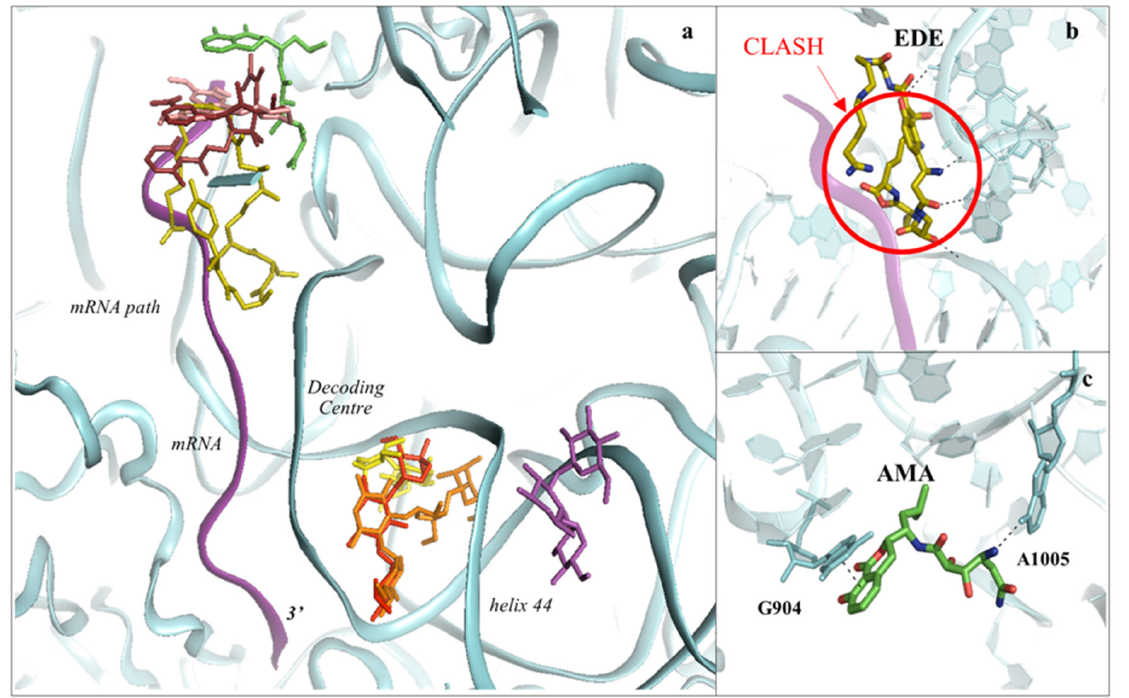
Figure 6. The SSU can be targeted by protein synthesis inhibitors at two main regions. ( a ) Overview of the binding sites for small molecules binding to the 40S subunit. Amicoumacin A (AMA) in green (PDB: 5I4L), cryptopleurine in salmon (PDB: 4U55), edeine (EDE) in olive green (PDB: 4U4N) and pactamycin (PAC) in ruby (PDB: 4U4Y). mRNA is also shown as a ribbon and coloured in purple. Inhibitors have been shown to bind with high specificity to the mRNA path and the decoding centre (DC), thus impairing tRNA–mRNA translocation and altering the translation fidelity process; ( b ) zoom-in and details of interaction for EDE within the mRNA path in correspondence with where the E-site tRNA should interact. The clash with mRNA (shown in red) would prevent the formation of the preinitiation complex; ( c ) zoom-in and details of interaction for AMA within the mRNA path. AMA forms a π – π stacking interaction with the conserved rRNA residue G904 while hydrogen bonding with the conserved A1005 (shown as dashed lines).